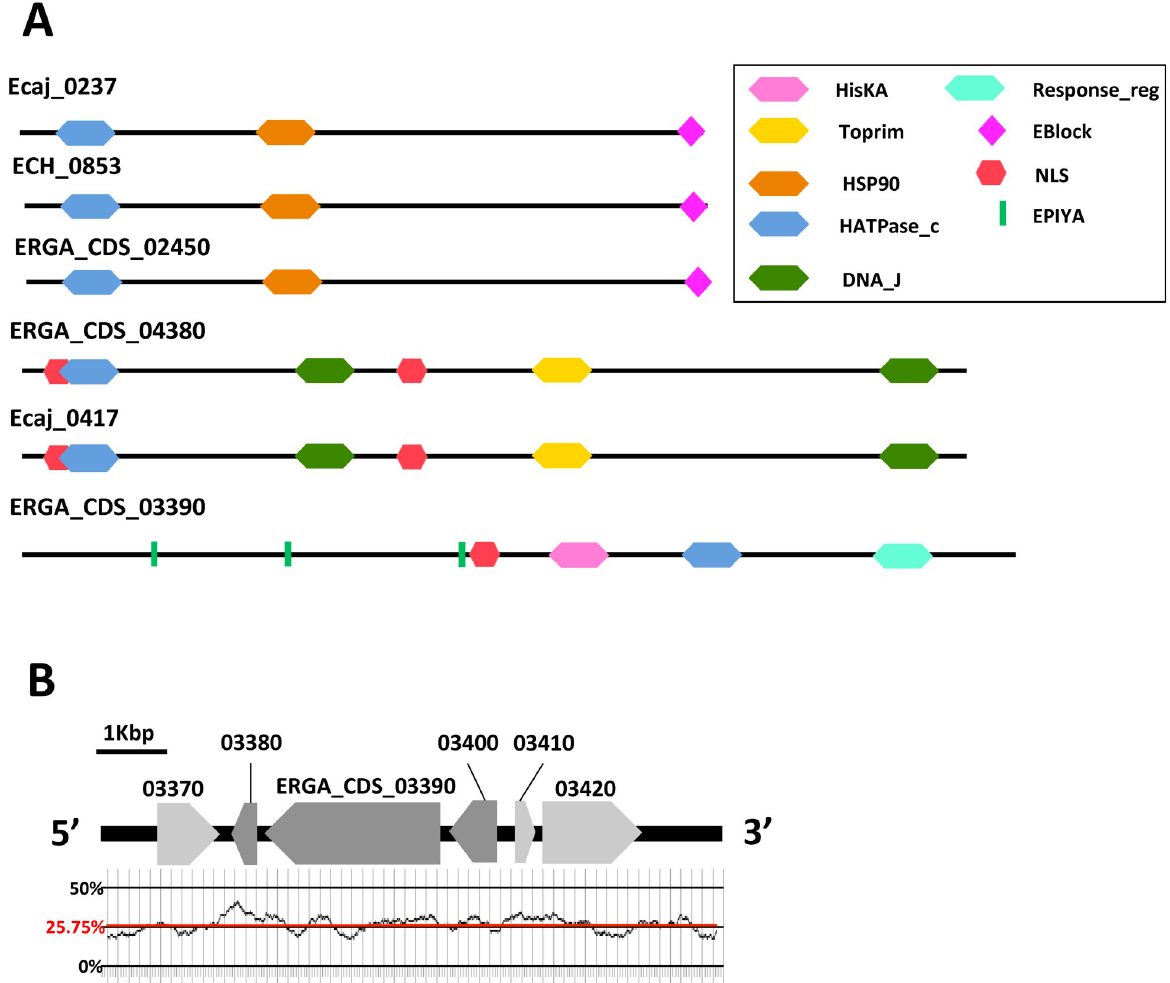
Fig 10. The strong domain diversity of HATPase_c-containing putative type IV effectors defines three conserved families of effectors in Ehrlichia spp. A. Each protein in Ehrlichia spp. type IV effectome whose architecture includes a HATPase_c domain is represented. B . Representation of the genomic context surrounding pT4E ERGA_CDS_03390 between position 557733 and 563669 of E . ruminantium str. Gardel genome. Pale grey arrows represent sense genes and dark grey arrows represent anti-sense genes. The GC content of this region of the genome was calculated using 200 bp windows and is represented by the black curve. The average GC content of this gene cluster (25.75% of GC) is indicated by the horizontal red